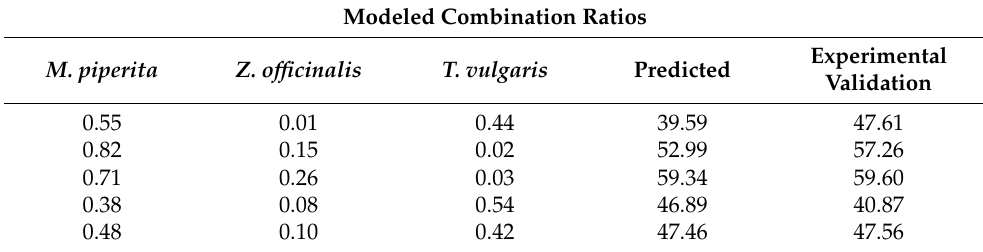
Table 5. Model validation for experimental runs using the FRAP